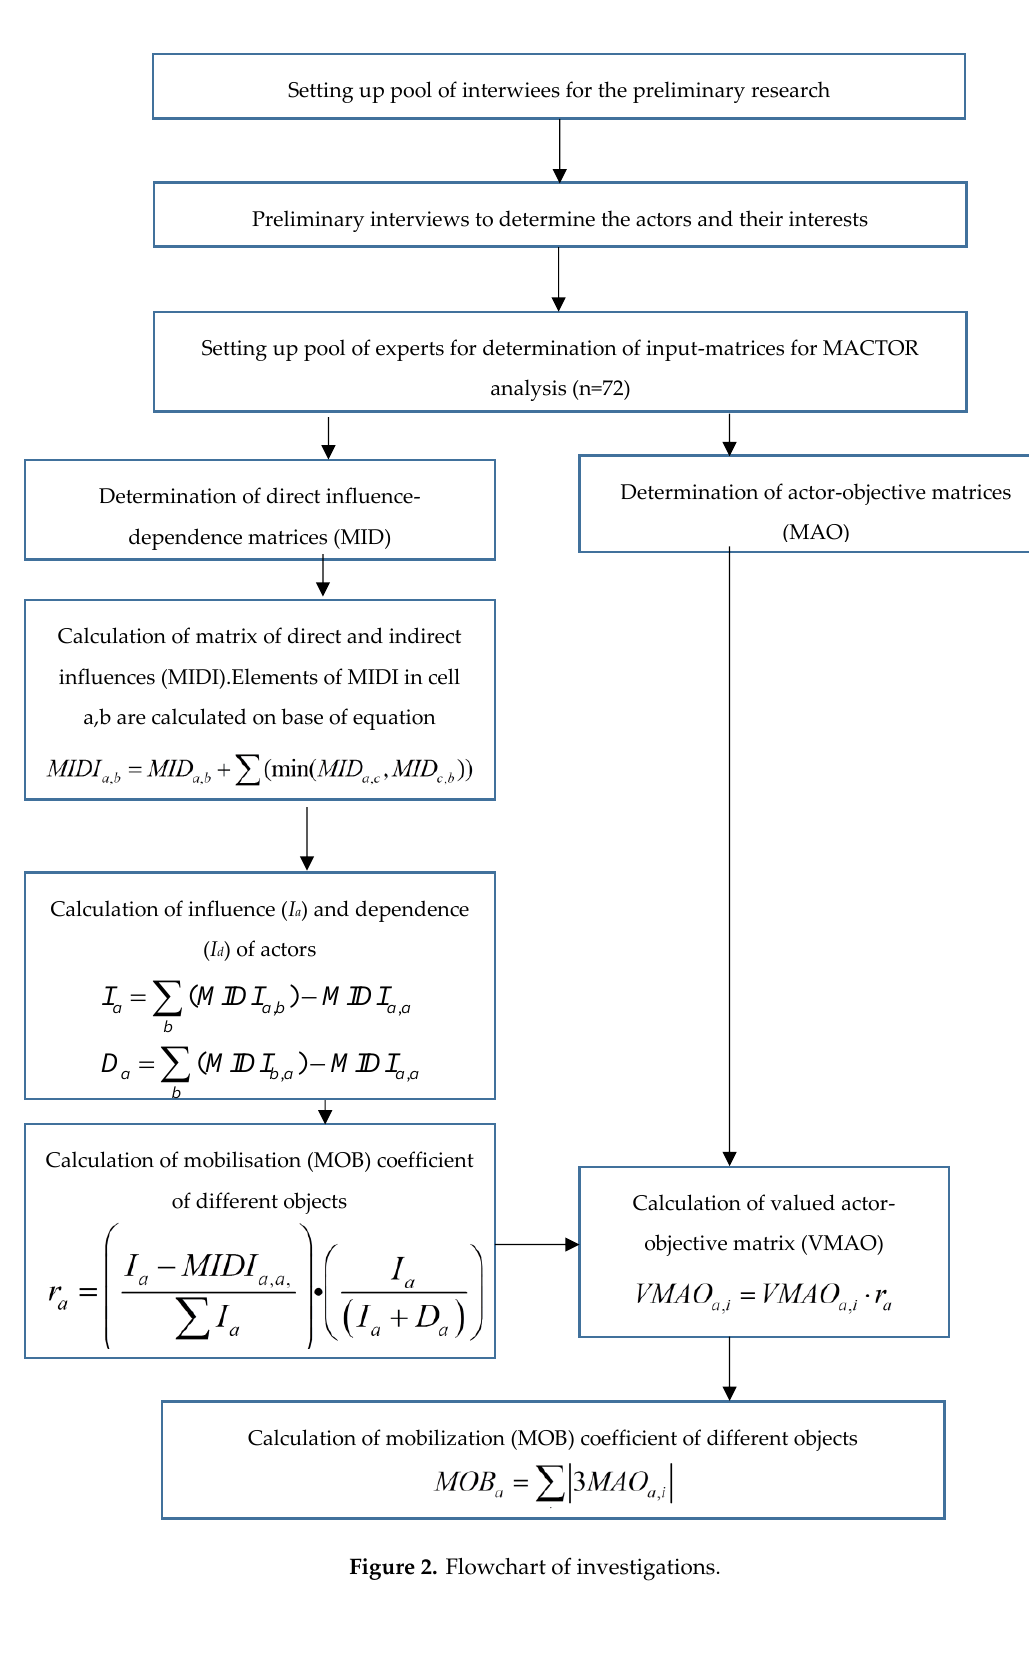
Figure 2. Flowchart of investigations.